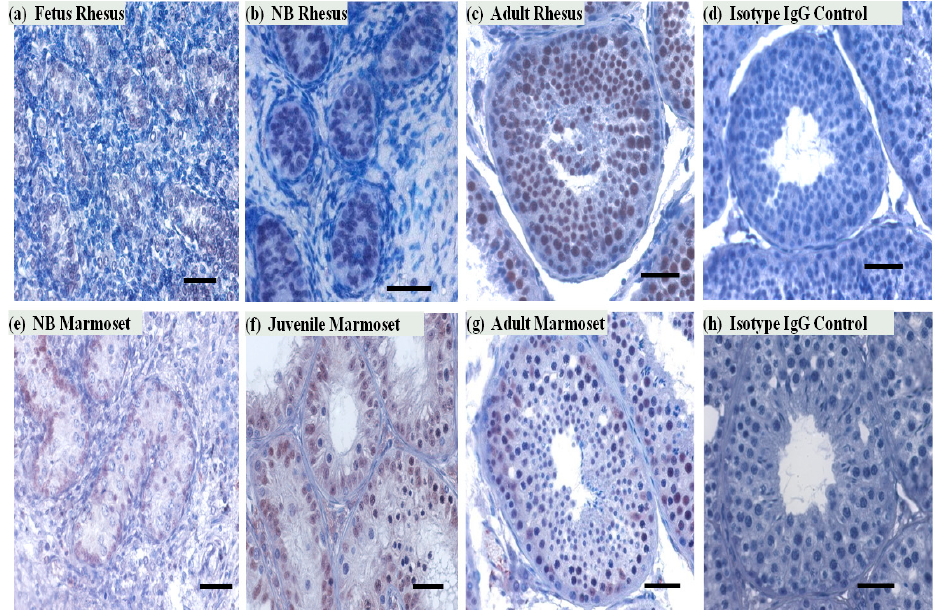
Figure 2. SIRT1 expression in rhesus and marmoset monkey testes during different developmental stages. ( a , b ) Very few SIRT1-positive cells were observed in fetal and NB (1 month) rhesus monkey testes in the seminiferous tubules. ( c , d ) In the adult rhesus testis, all seminiferous tubule cross sections contained many SIRT1 positive germ cells. No staining was noted in control Immunoglobulin ( IgG) antibody incubated testicular cross section of rhesus monkeys. ( e , f ) In NB (5 days) and juvenile (5–6 months) marmoset testes, SIRT1 positive cells were mainly observed in the tubular compartment. No staining was observed with control antibody (isotypic IgGs). ( g , h ) In the adult common marmoset testis SIRT1 was detected in germ and Sertoli cells. Scale bars, 50 µm.